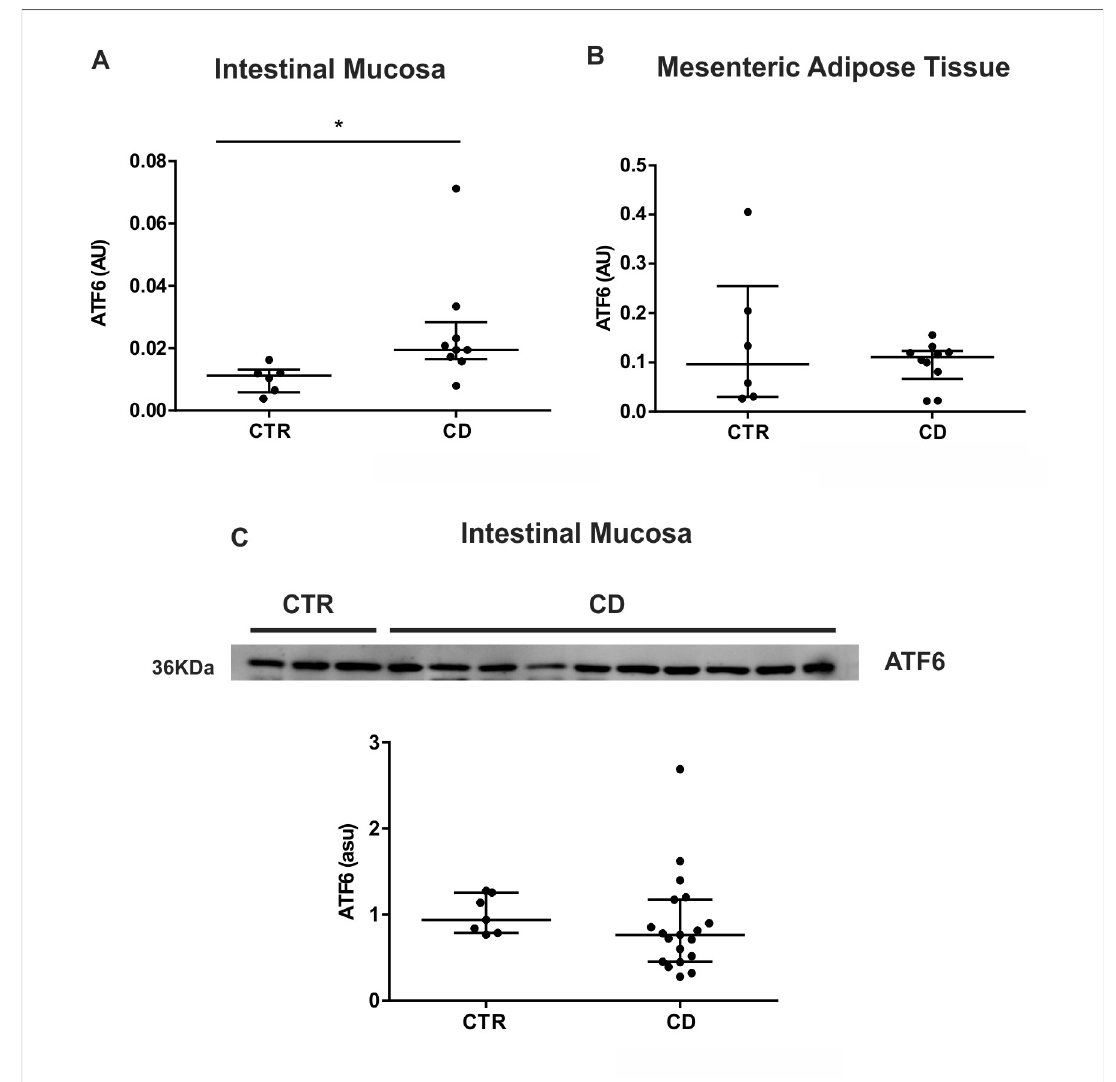
Fig 2. Activation of ATF6 pathway in the intestinal mucosa and in the mesenteric adipose tissue (MAT) of Crohn’s disease patients. mRNA levels (qRT-PCR) of ATF6 gene was investigated in the intestinal mucosa (A) and in MAT (B) of CD patients (CD group) compared to control group (CTR group). Western blot analysis of the cleaved form of ATF6 protein was evaluated in the intestinal mucosa of CD patients (CD Group) compared to controls (CTR Group) (C). Each band represents one patient. � p < 0.05 and �� p < 0.01 are considered statistically significant versus control group. AU: arbitrary unit. ASU: arbitrary scanning